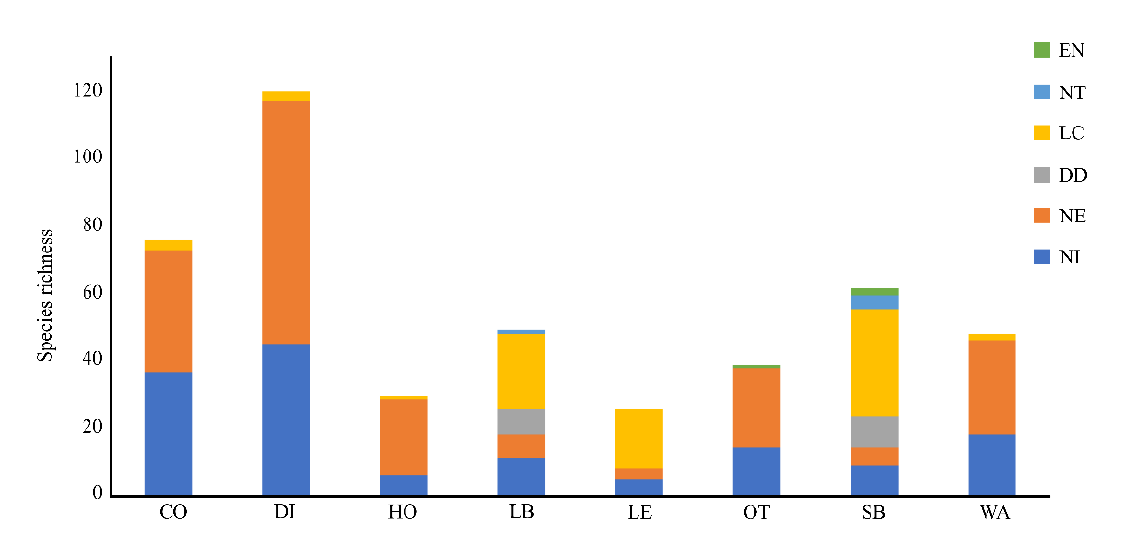
Figure 5: Number of pollinator species for each functional group that belong to the different IUCN categories, including the group of non-identified insects (NI) and those not yet evaluated (NE). The functional groups are Coleopterans (CO), Dipterans (DI), Hoverflies (HO), Large bees (LB), Lepidoptera (LE), Others (OT), Small bees (SB) and Wasps (WA). The IUCN conservation status is Data Deficient (DD), Endangered (EN), Least Concern (LC), and Near Threatened (NT). Data from 2008 to 2011 are pooled. Specifically, 76% of the species of small bees (SB), 68% of lepidopterans (LE) and 62% of large bees (LB) could be assessed. In contrast, the percentages for the rest of the functional groups fell between 2 and